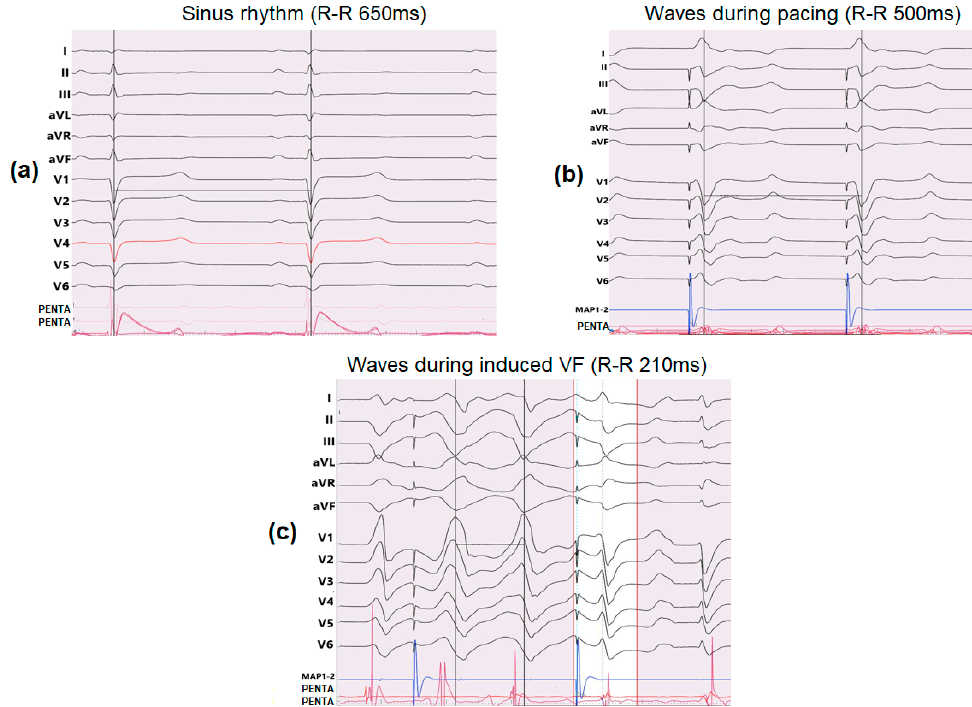
Figure 9. Examples of iEGMs and reference ECG waves in pig #3 at 9 weeks post-DOX, during: ( a ) sinus rhythm; ( b ) pacing from RV at 2 Hz resulting in a cardiac cycle length of 500 ms; and ( c ) induced ventricular fibrillation (VF) that resulted in a fast cycle length of 210